Question: Based on the figure, does the quantity rise or fall?
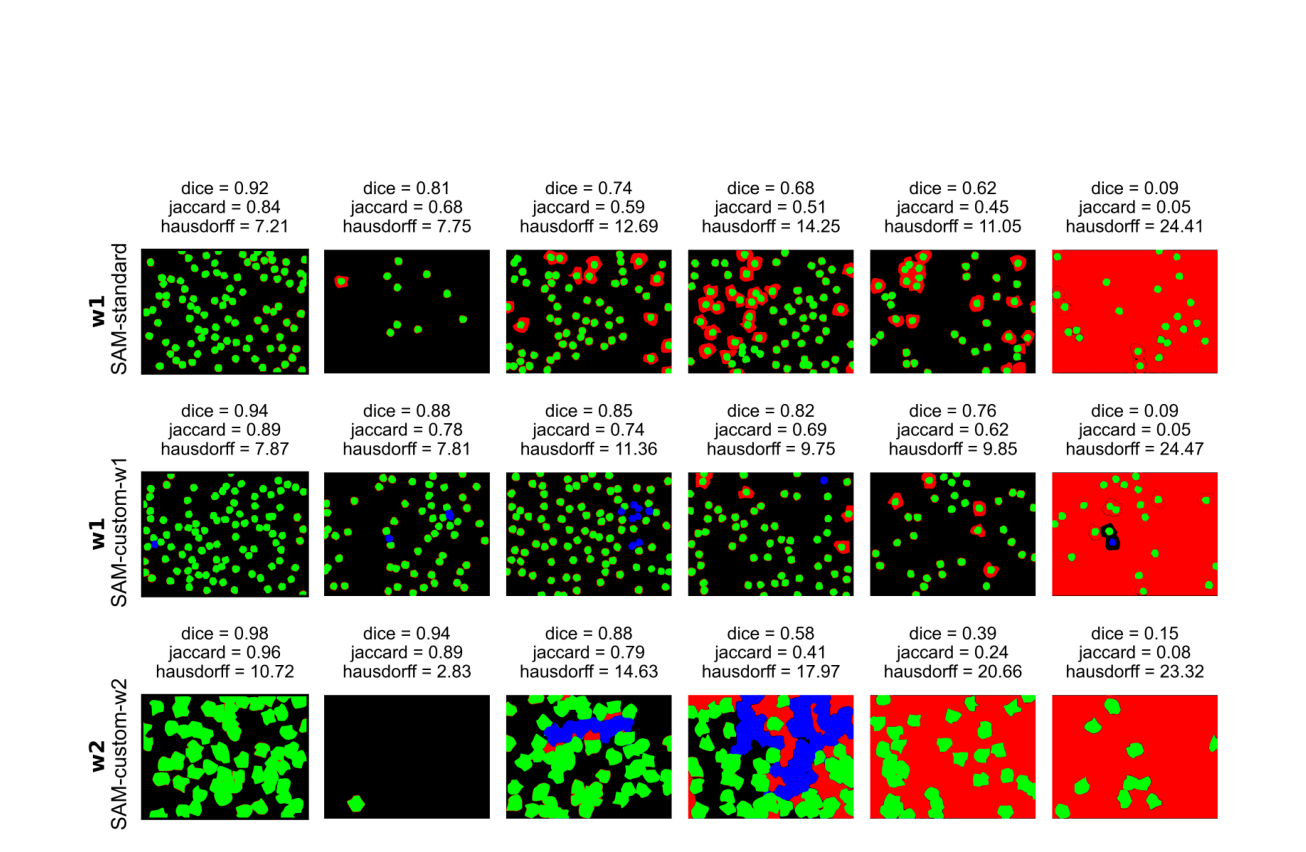
Answer: decreasing